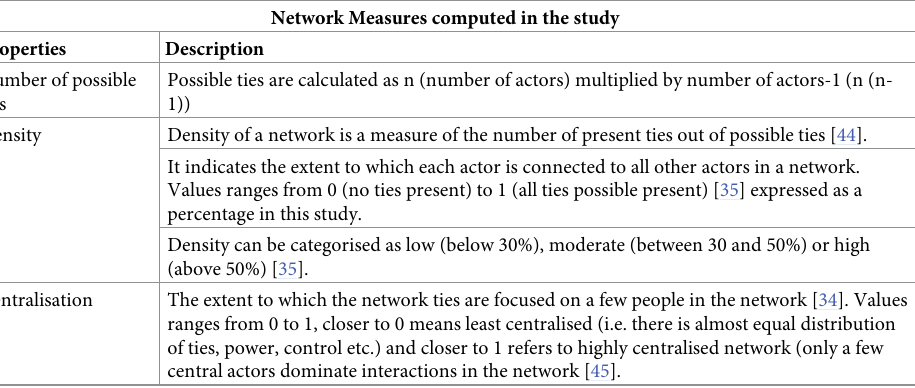
Table 1. Network measures computed in the